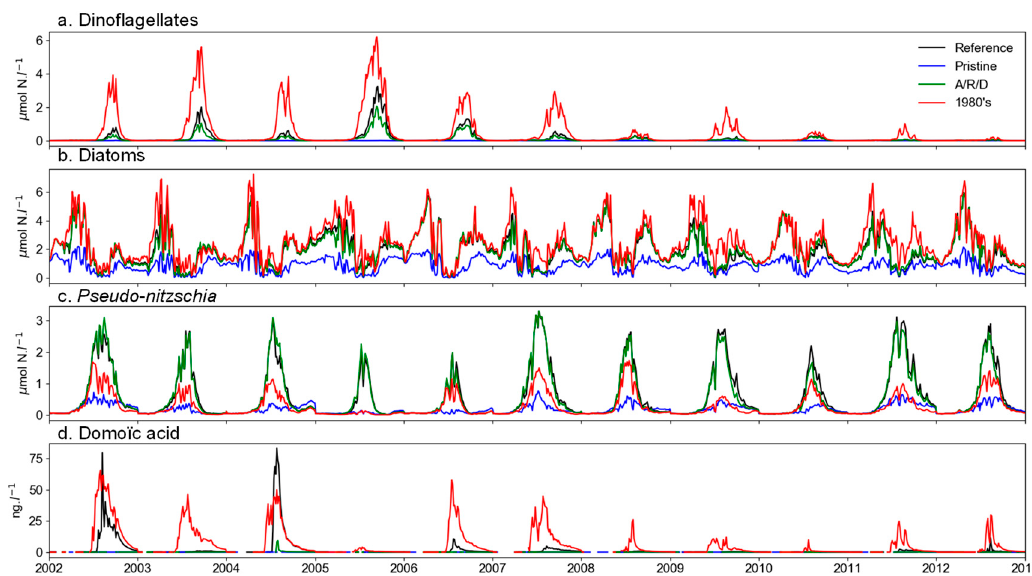
Figure 9. Seasonal and inter-annual simulated variations (ECO-MARS3D) of major phytoplankton variables at the coastal zone station Antifer. From top to bottom: biomass of ( a ) dinoflagellates; ( b ) diatoms; ( c ) Pseudo-nitzschia ; and ( d ) domoic acid concentration. Comparison of the reference situation (2002–2012; Ref) with three scenarios (Pristine, 1980s, and A/R/D (autonomy/reconnection/demitarian diet)).